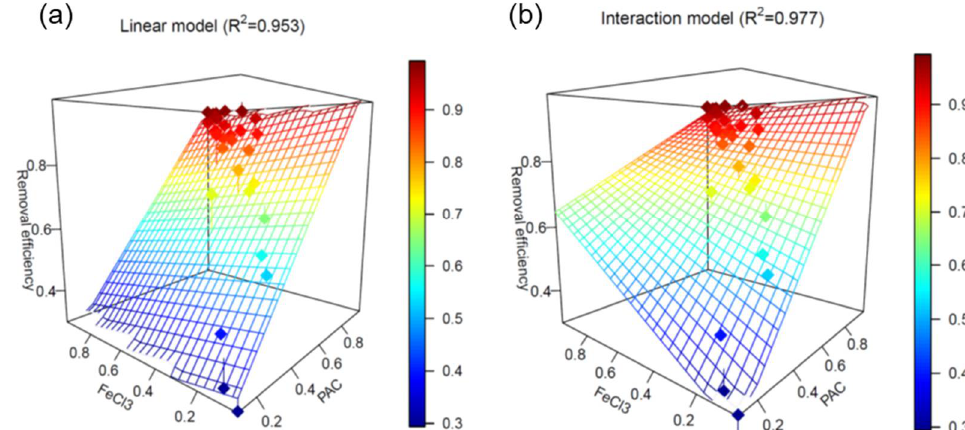
Figure 2. Three-dimensional plots of the ( a ) linear and ( b ) interaction models for the phosphate removal efficiency using coagulant combination (PAC + FeCl 3 ) to individual coagulants (PAC or FeCl 3 ).